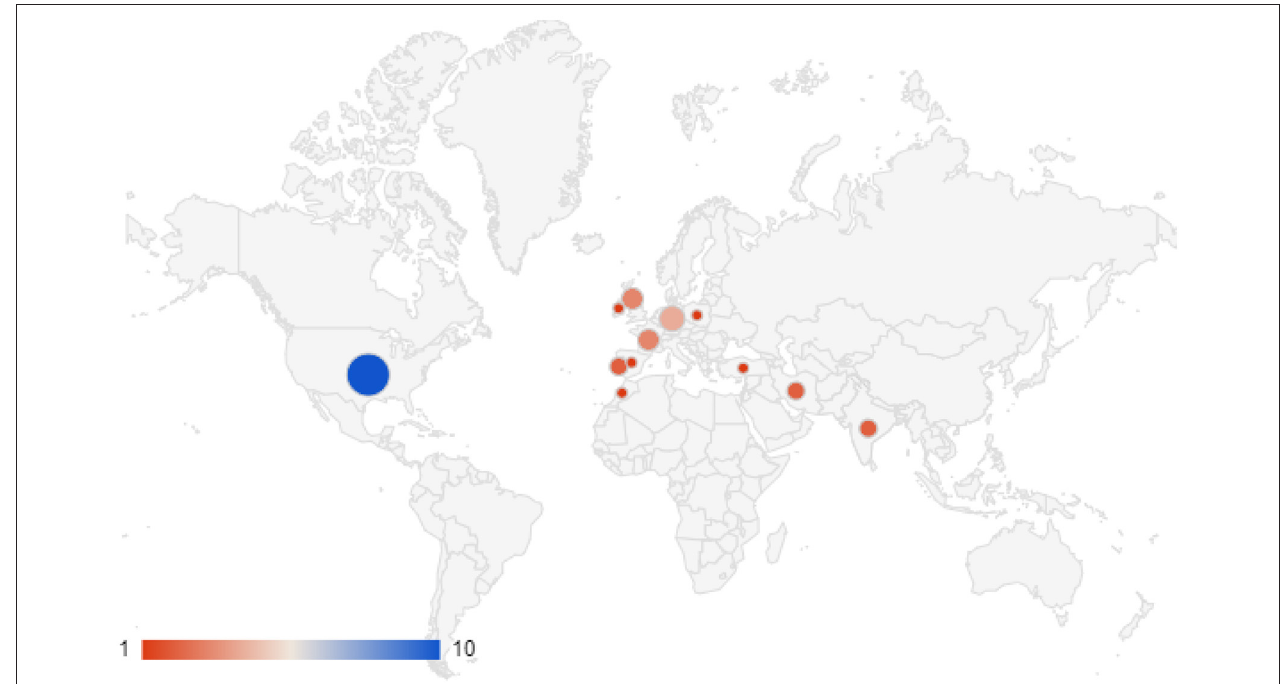
FIGURE 2 | Case reports of clinical lycanthropy and kynanthropy in the scientific literature (1970–2020): geographical